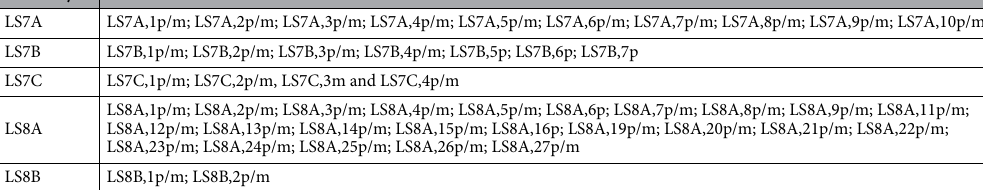
Table 1. List of the tracks that belong to each studied trackway from the Las